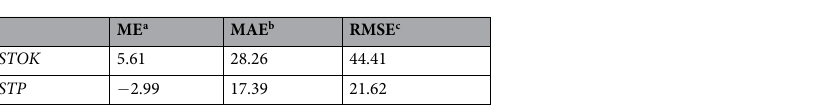
Table 2. Comparison of the BC incidence estimations accuracy of the STP and STOK techniques. a Mean